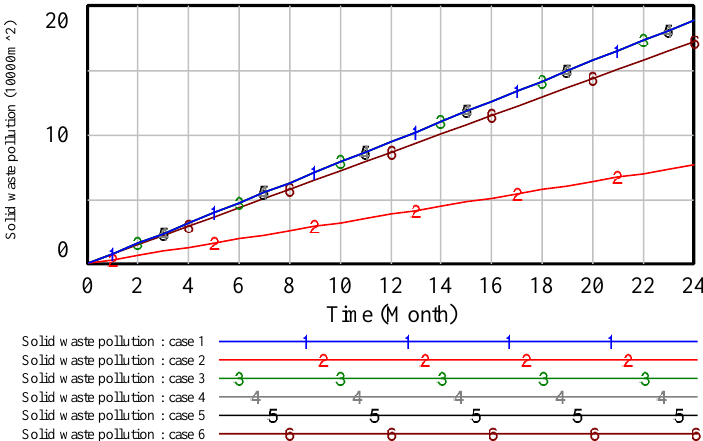
Figure 9. The simulation result of solid waste pollution.